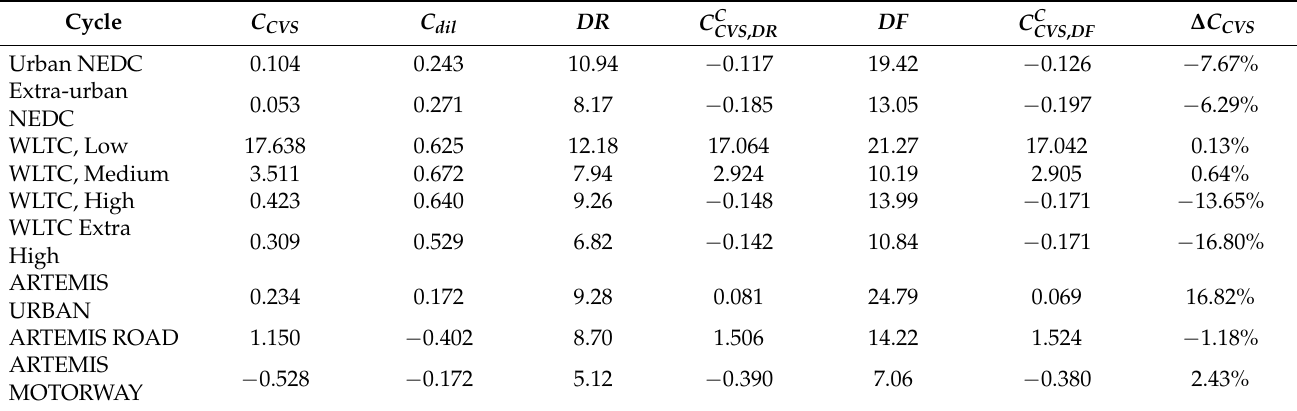
The C CVS,corr calculated based on Equations (5) and (21) for Euro 5 vehicle with CI engine, CO concentration [ppm].